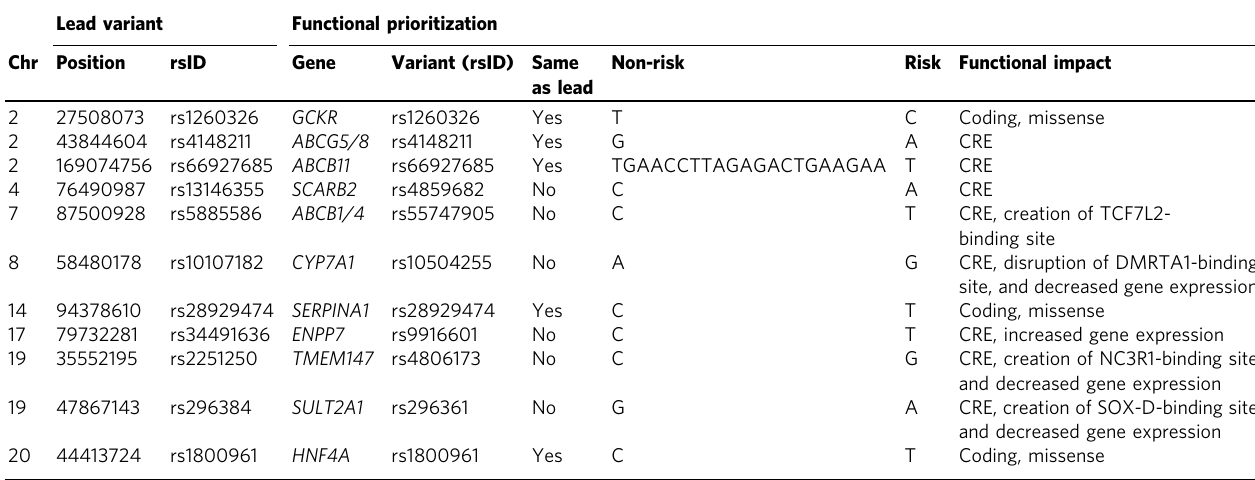
The chromosome (Chr), position (Build 38), and rsID are given for the lead variant (variant with the lowest P value) in each locus are shown along with the gene, rsID, risk, and non-risk alleles and functional impact following in silico functional